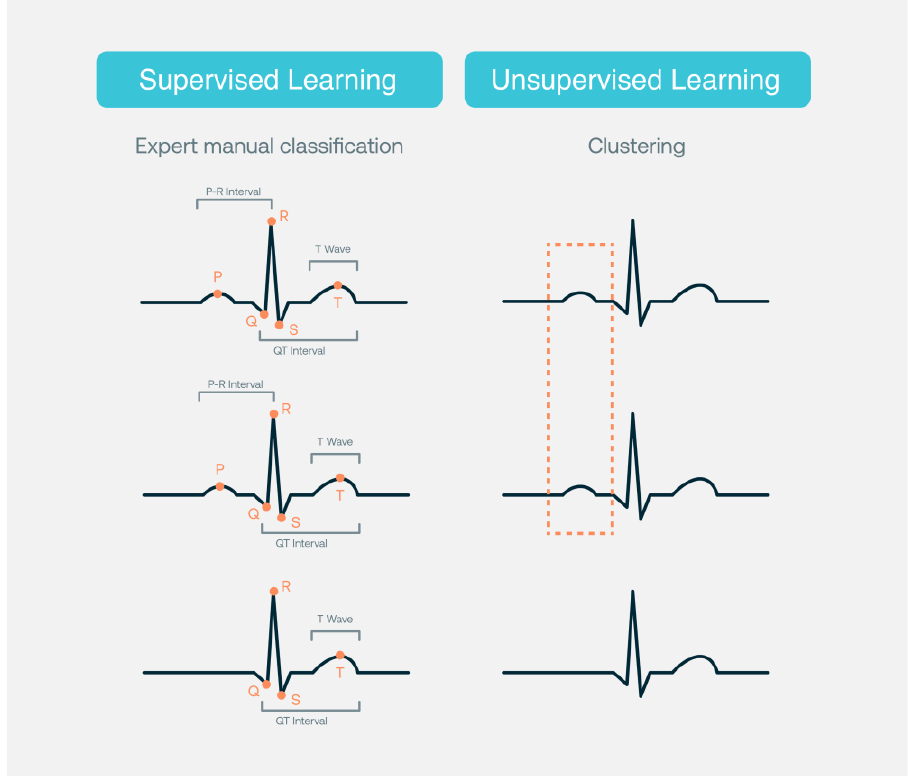
Figure 1. Supervised and unsupervised learning.